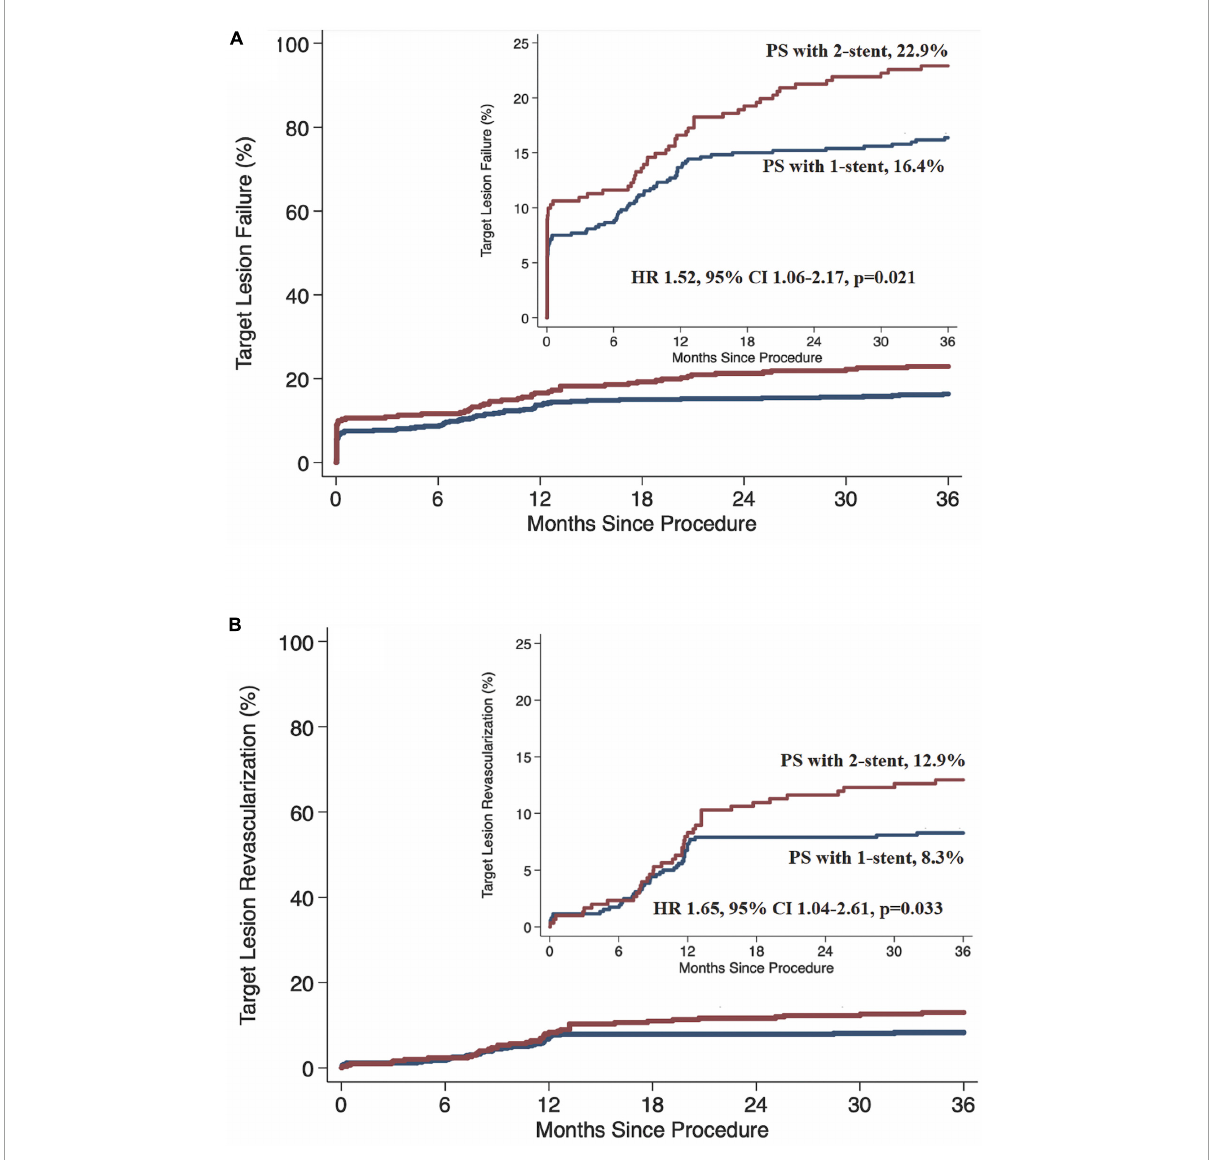
FIGURE2 Kaplan–Meier survival rate. PS, provisional stenting; HR, hazard ratio; CI, confidence interval. (A) Target lesion failure. (B) Target lesion